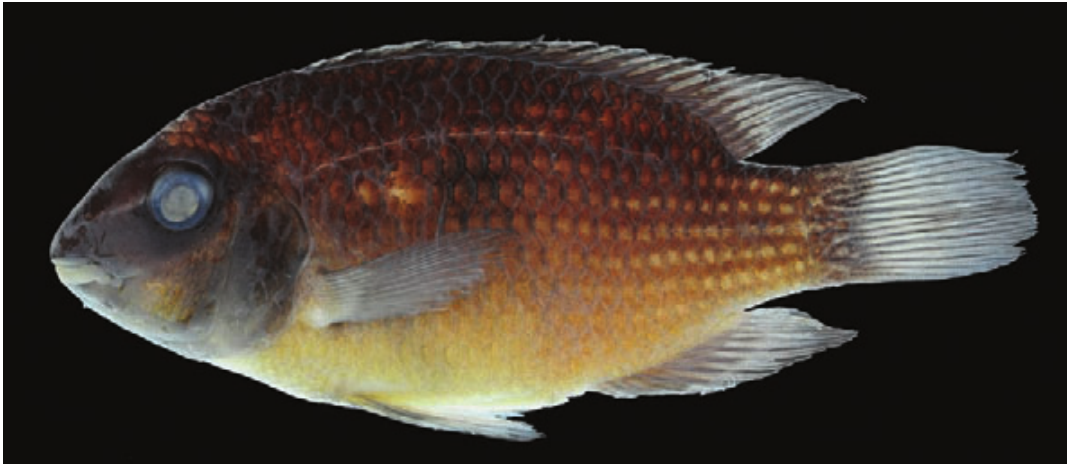
Fig. 11. Mazarunia pala , holotype, UG/CSBD 1668, 65.2 mm SL, Guyana, Cuyuni-Mazaruni (Region 7), Mazaruni River, backwater channel on right bank in front of Warwata village, near mouth of Kamarang pattern of brownish-maroon and pink dorsally from E1, more or less uniformly pinkish grey below E0. Midlateral spot of darker black pigment between 8 th and 10 th dorsal spines, about 3 scales wide and 2 scales deep, entirely under upper lateral line, or barely overlapping it. Dorsal fin mostly maroon or reddish brown, first spine and distal tips of spines and membrane lappets dark gray for all of spinous portion, soft portion with maroon widely outlining rays, but transparent on distal 1/3 of soft rays. Dorsal-fin spines darker than membranes. Pectoral fin transparent, rays thinly outlined with black. Pelvic whitish or light pink, spine and anterior rays outlined in black. Anal fin maroon to pink along base then translucent or dark gray distally, latter probably reproductive adults. Caudal fin dusky gray proximally, black pigment extending along rays for about 1/3 of their lengths, membranes lightly dusky to greyish pink.